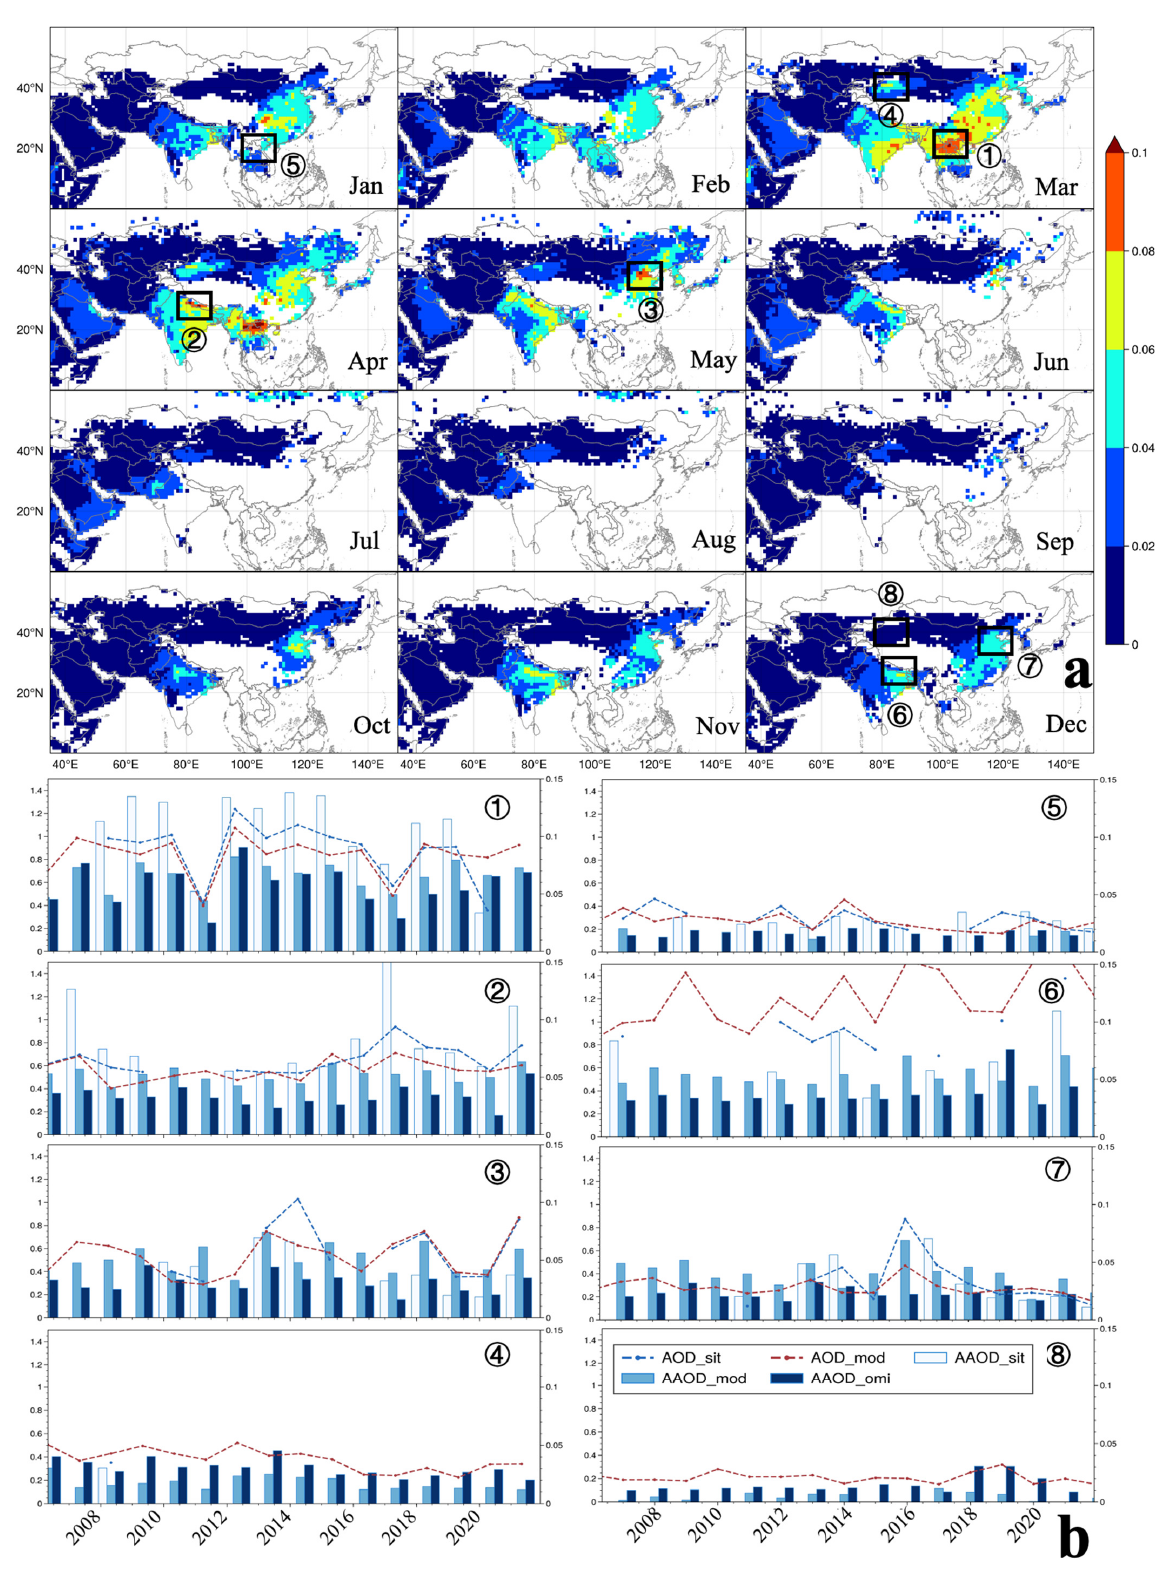
Figure 3. ( a ) Monthly AAOD from MODIS-OMI from 2006 to 2021; ( b ) the time-series variations of AERONET AOD (dotted blue line), MODIS AOD (dotted red line), AERONET AAOD (white column), MODIS-OMI AAOD (light blue column), and OMI AAOD (blue column) at the corresponding